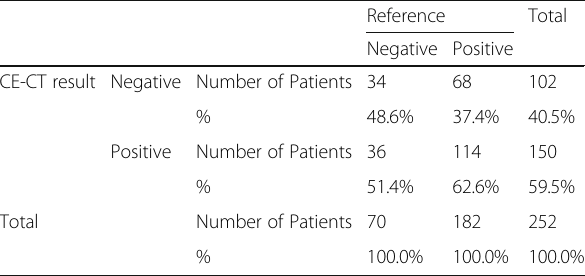
Table 4 Agreement of CECT with the reference modalities in detection of post-therapeutic colon cancer recurrence and metastasis (lesion-based analysis n = 252) crosstab